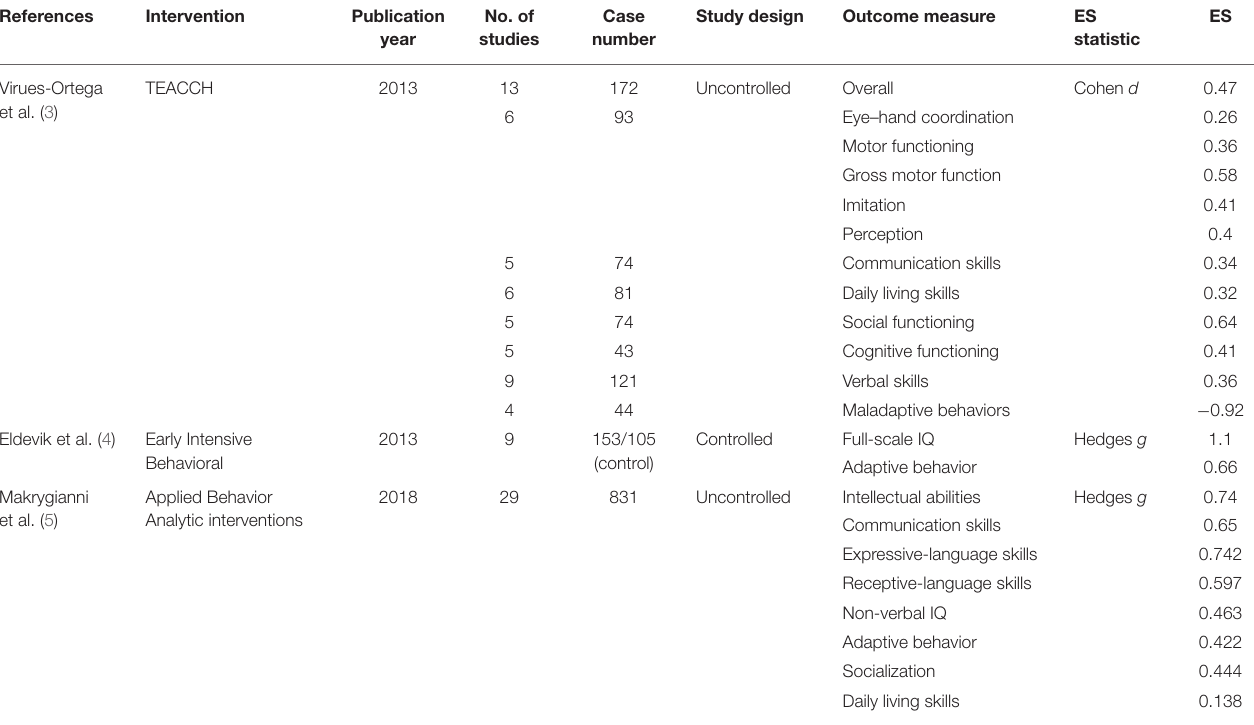
TABLE 5 | Characteristics and effectiveness of three of the conventional rehabilitation